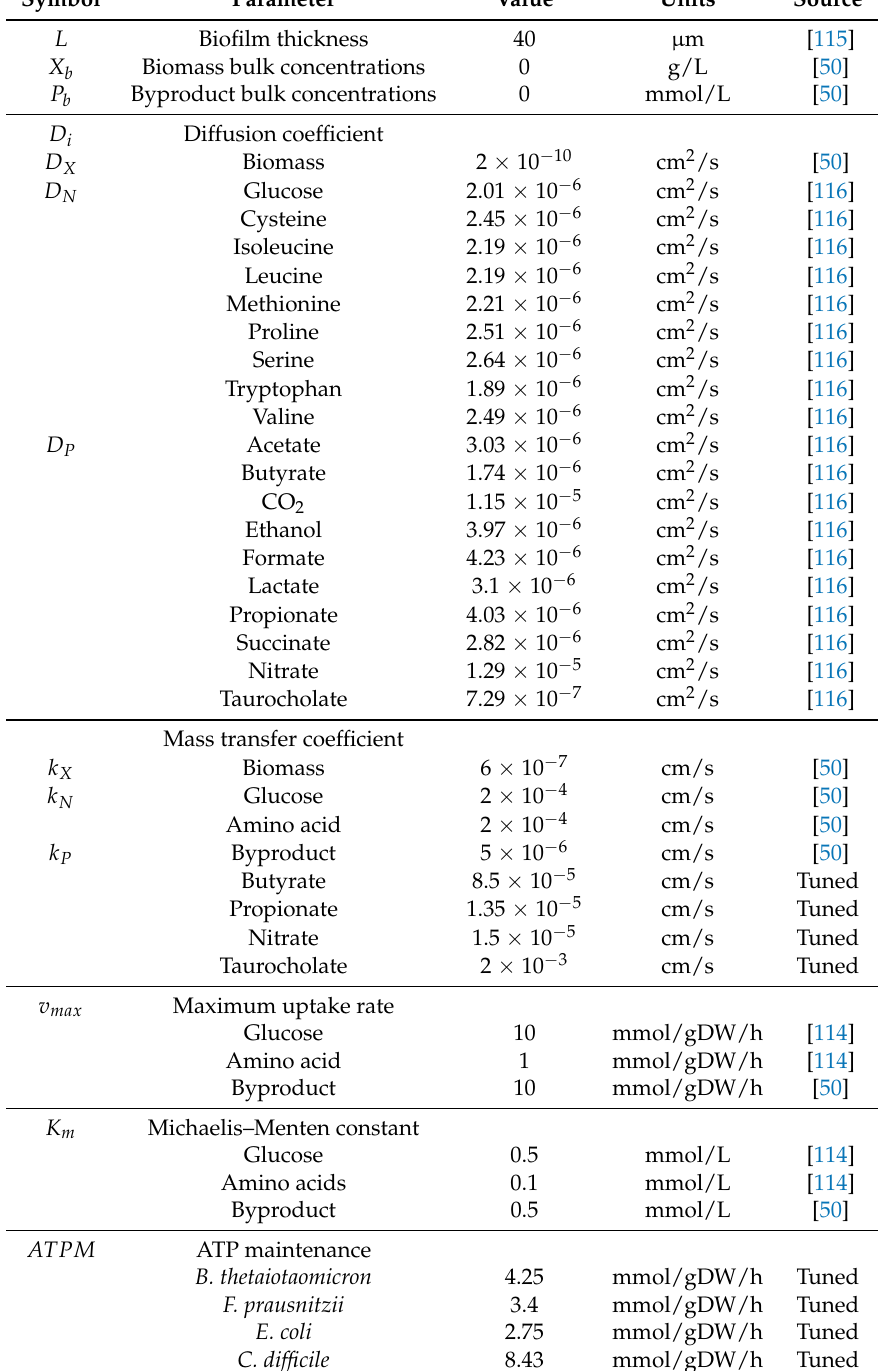
Table 2. Nominal parameter values for the multispecies biofilm